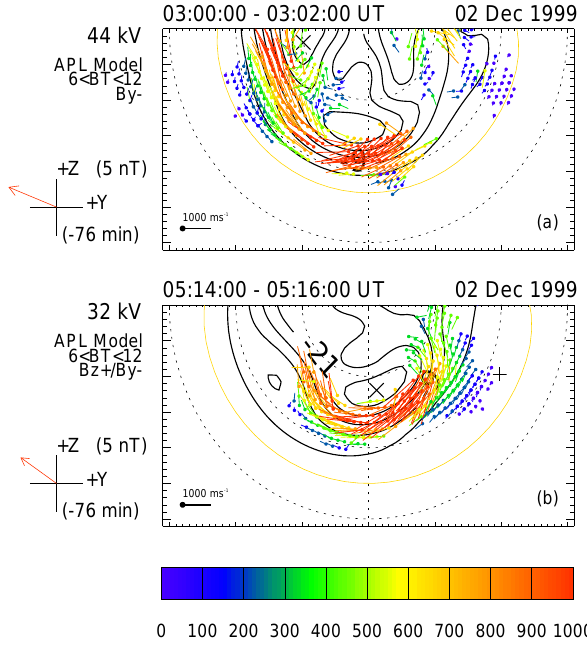
Fig. 1. Streamlines and vectors of the nightside ionospheric flow derived from the SuperDARN velocity measurements shown on geomagnetic grids, obtained from the “Map-Potential” algorithm, showing two flow bursts during an interval of northward but B Y - negative dominated IMF. The exact time interval of each map is indicated in the top left-hand corner, and to the left of each map the total transpolar voltage V PC , and the direction and magnitude (in the Y - Z plane) of the lagged IMF are also indicated (adapted from Grocott et al., 2003).